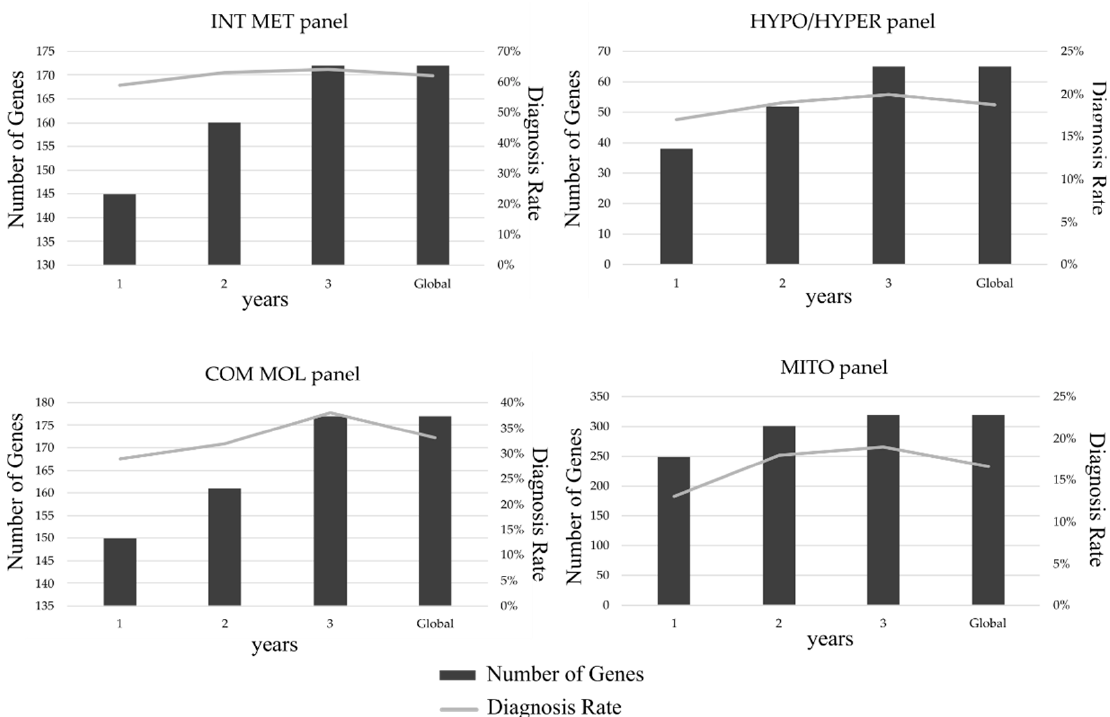
Figure 1. Changes in the rate of positive diagnosis (grey line) with the addition of new genes (dark bars) to each of the multi-gene panels over the 3-year study period. Global values represent the mean rate of positive diagnosis.